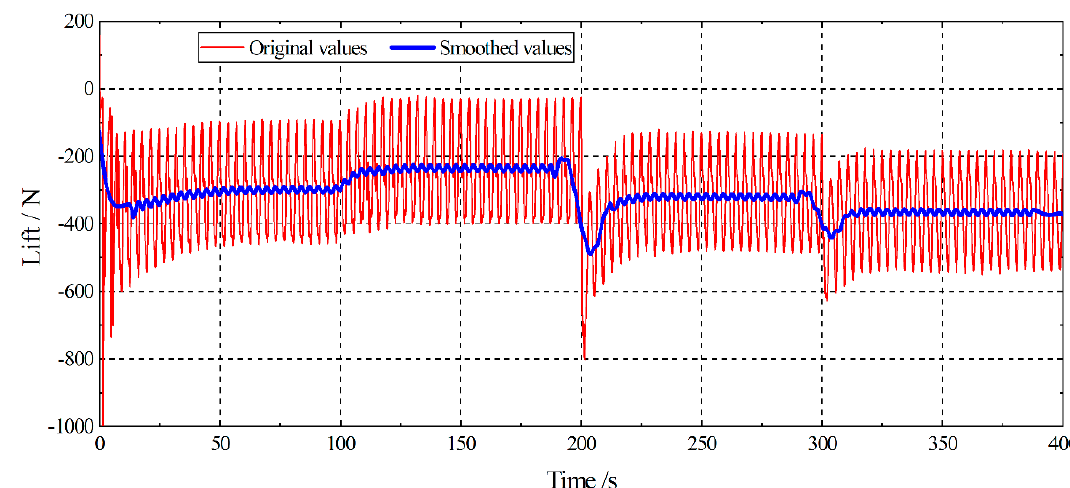
Figure 17. Time history of lift of the towed vehicle.